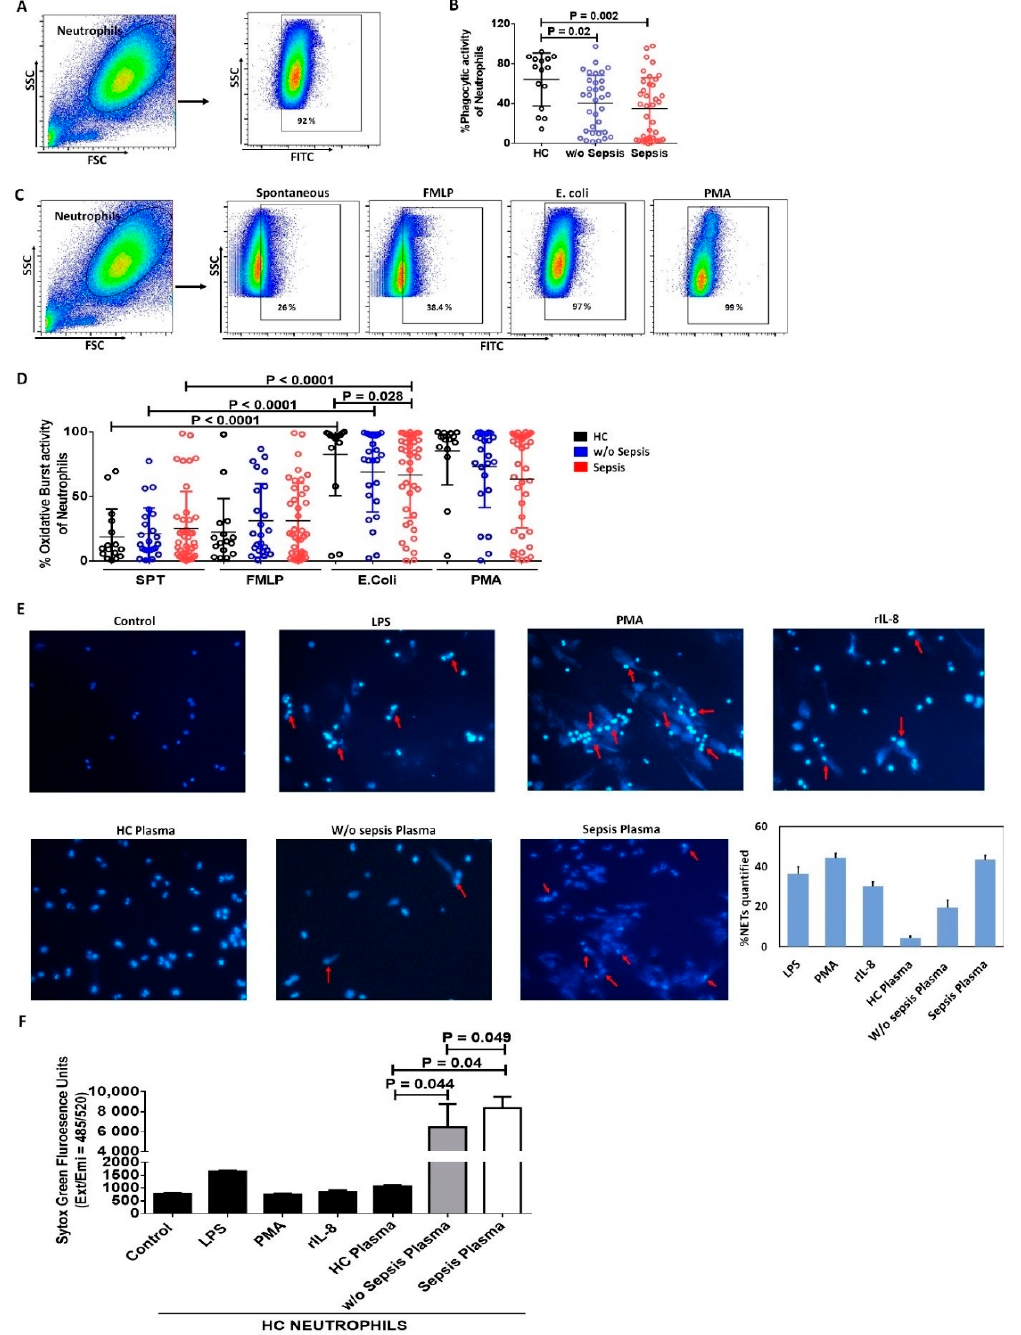
Figure 2. Functionality of neutrophils. ( A ) Gating strategy for phagocytic activity of neutrophils. ( B ) Scatter dot plot shows phagocytic activity of neutrophils between the groups. ( C ) Gating strategy for oxidative burst activity of neutrophils both spontaneously and stimulation with FMLP, E. coli and PMA. ( D ) Scatter dot plot shows oxidative burst activity of neutrophils between the groups. ( E ) Representative images of NETs in healthy control neutrophils without and with stimulation i.e., LPS, PMA, rIL-8, HC plasma, w / o sepsis and sepsis patient plasma at 40× along with the % NETs quantification using ImageJ software. ( F ) Cell free DNA was estimated using sytox green fluorescence units captured on exi/emi = 485/520 in supernatant without and with stimulation. SPT (spontaneous), LPS (Lipopolysaccharide), PMA (Phorbol 12-myristate 13-acetate), rIL-8 (recombinant IL-8). Results are expressed as the mean ± SD; One-way ANOVA/Kruskal–wallis test followed by probability adjustment by the Mann–Whitney.